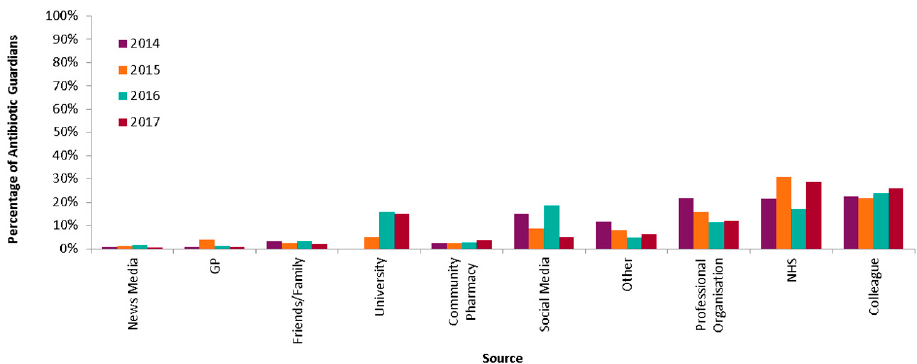
Figure 5. Percentage of AGs by source of hearing of the AG campaign 2014–2017.